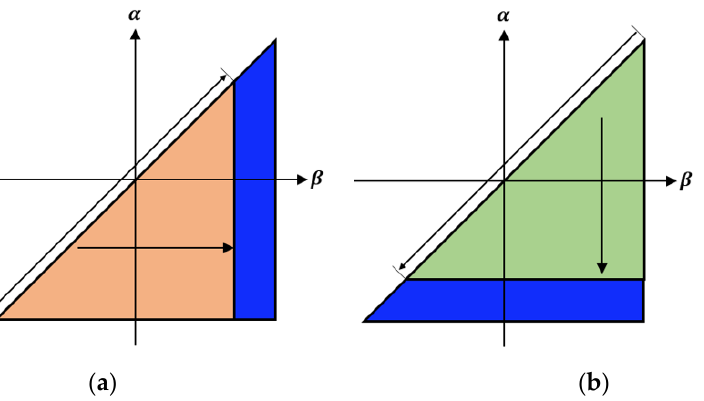
Figure 6. The trace according to the increase or decrease in the input on the Preisach plane ( a ) when the input increases and ( b ) when the input decreases.